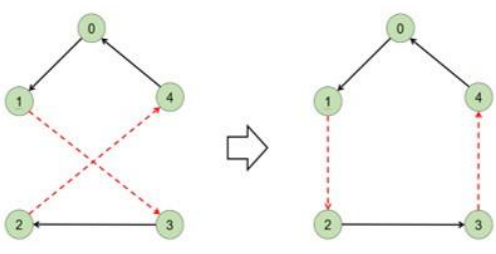
Figure 2. 2-opt Swap Method Concept (a).